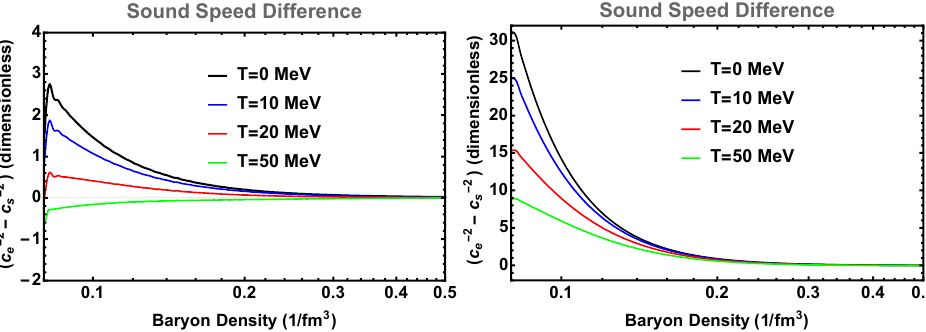
Figure 4. The difference between the inverse of the squares of the equilibrium and adiabatic sound speeds as a function of density in the neutron star core for varying temperatures, for the APR EOS. A positive difference indicates stable g -modes. ( a ) For Y p the same as that given by the cold EOS (i.e., in β -equilibrium), at temperatures of 50 MeV or more, no stable g -modes are supported. ( b ) For a fixed, arbitrary Y p = 0.1, this difference, though positive at low density eventually turns negative at large density irrespective of the temperature. Interpolation effects at the core-crust boundary ( n B = 0.08 fm − 3 ) cause the peaks in the left panel figure and do not have any physical significance. In practice, the sound speed difference in the core rises smoothly towards the core-crust boundary and drops abruptly to 0 in the crust in accordance with our assumption of a homogeneous fluid crust (see text for additional discussion on this point). The corresponding results for the ZL EOS are qualitatively